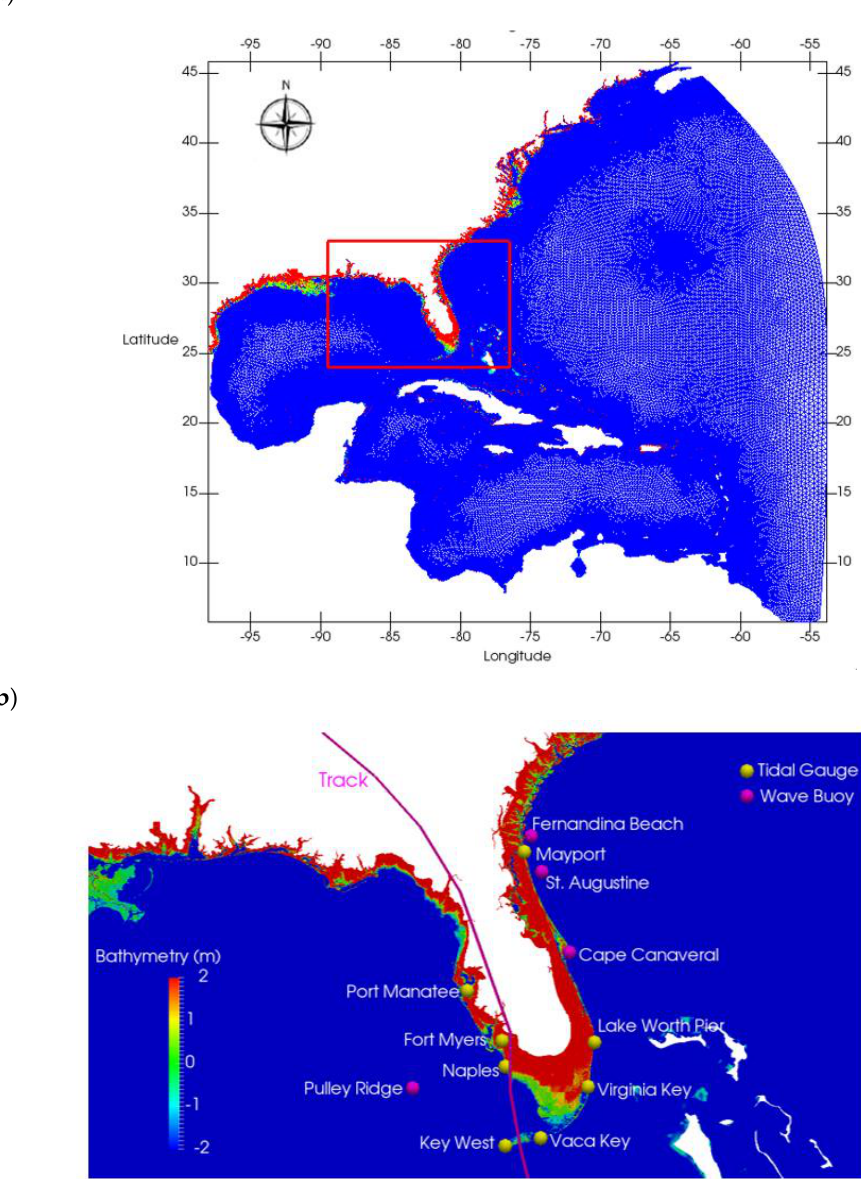
Figure 1. Model domain: ( a ) unstructured mesh, and the area of study marked with a red box; ( b ) locations of tidal gauges and wave buoys, and the track of Hurricane Irma within the area of